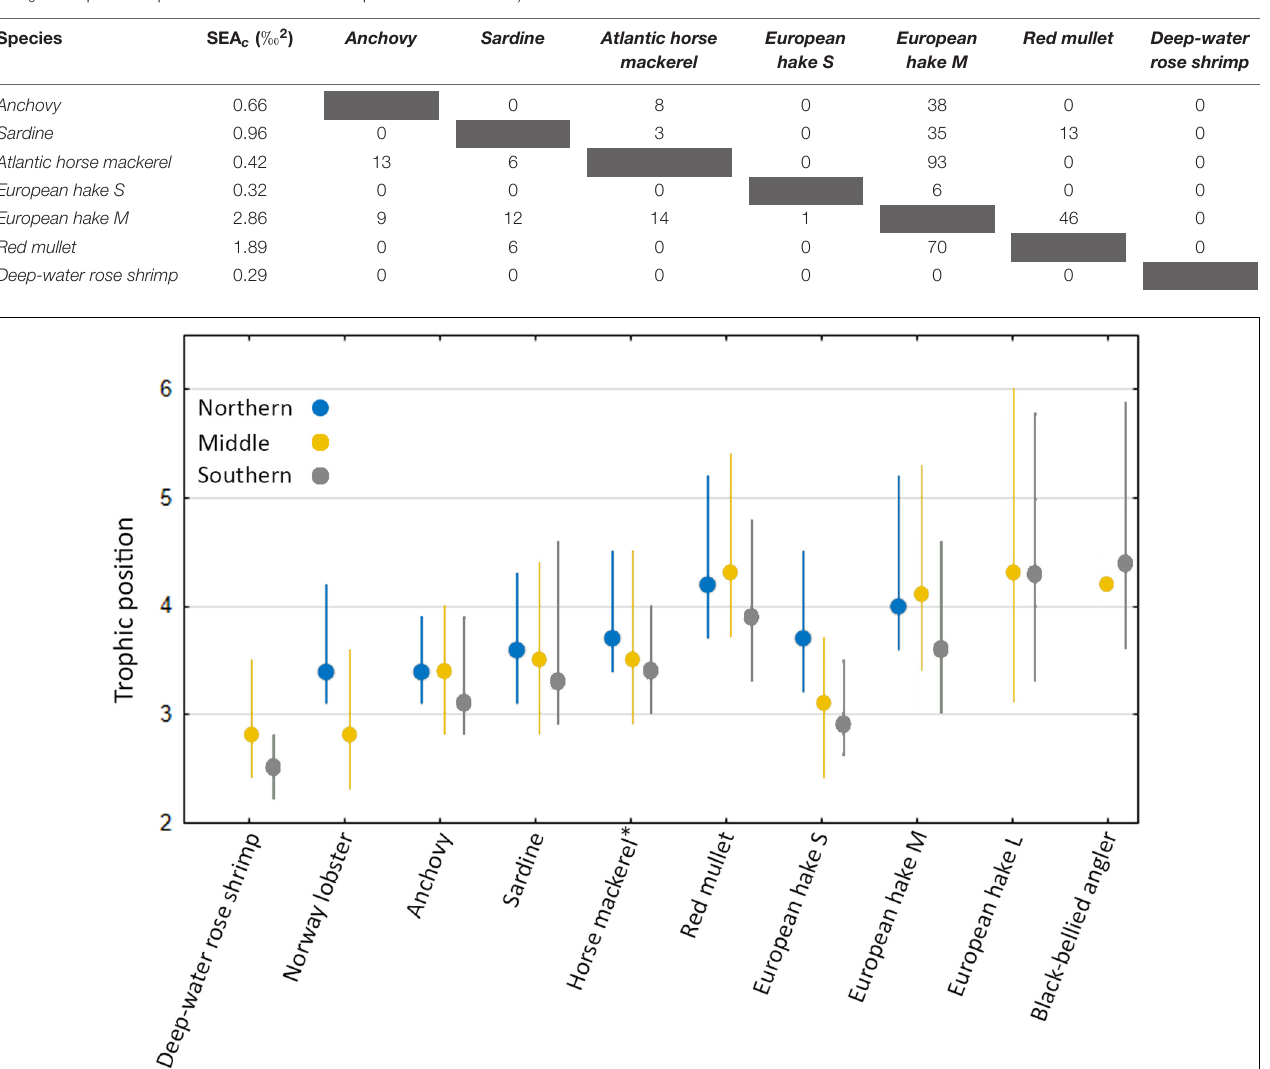
FIGURE 5 | Modal (95% Bayesian credibility intervals) estimated trophic position for each of the fish species examined from the Northern, Middle and Southern areas of the Croatian part of the Adriatic Sea. *Mediterranean horse mackerel in the Northern and Middle areas and Atlantic horse mackerel in the Southern area.